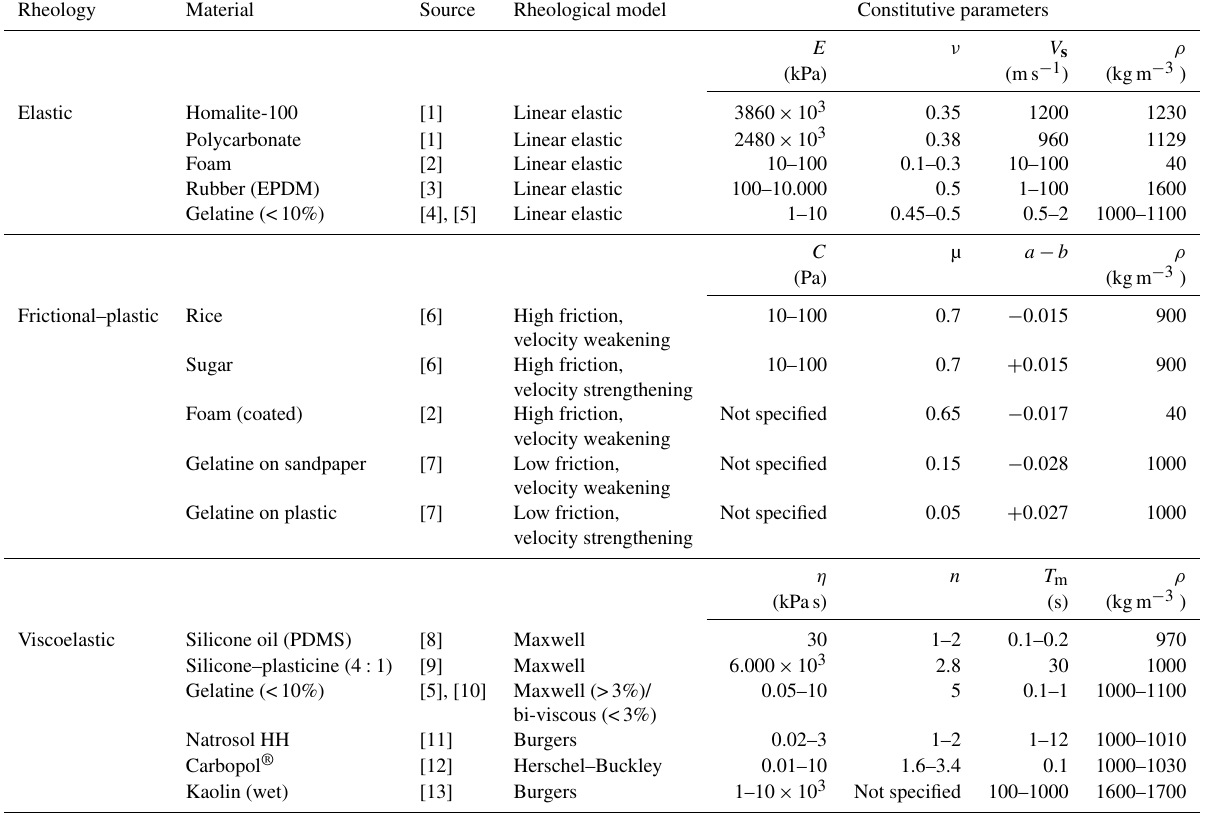
Table 4. Mechanical properties of selected rock analogue materials under typical laboratory conditions (see text for discussion).